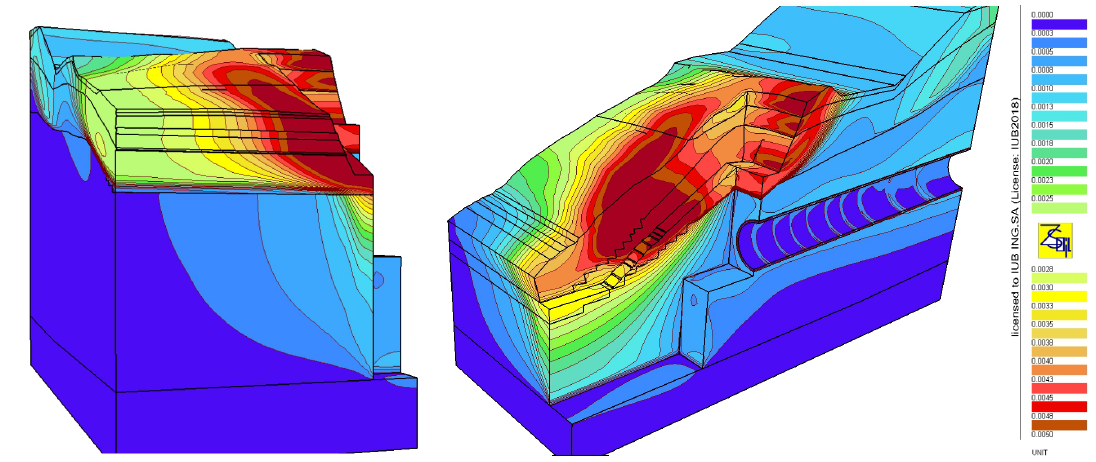
Figure 9. Slip failure of the weathered OSM in ϕ -c reduction for the final state (FoS = 3.0); colours of abs. displacements as before.